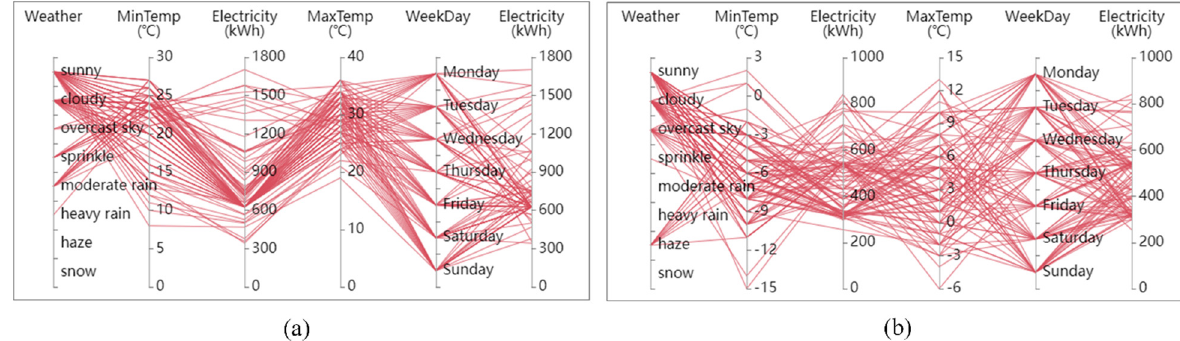
Figure 8. Analysis of factors influencing electricity consumption. ( a ) Electric consumption of July– September 2018. ( b ) Electric consumption of December–February 2019.